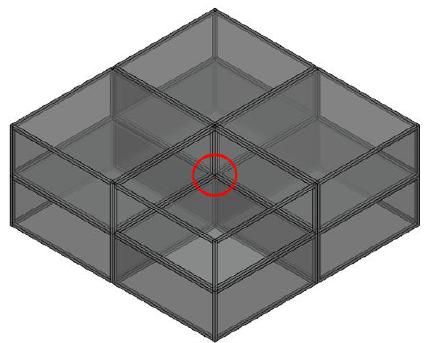
Figure 6. Connection.